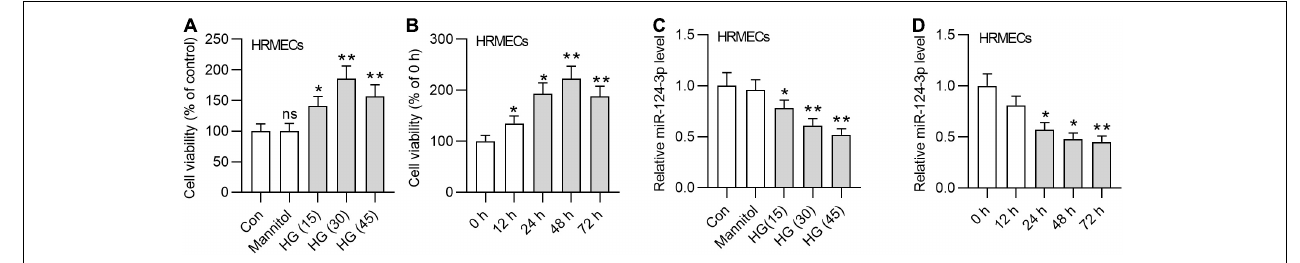
FIGURE 1 | MiR-124-3p was downregulated in HG-stimulated HRMECs. (A) The viability of HRMECs treated with 5 mM glucose, 5 mM glucose plus 30 mM mannitol, 15 mM glucose, 30 mM glucose, 45 mM glucose for 24 h was detected by CCK-8 assay. (B) The viability of HRMECs treated with 30 mM glucose for 0 h, 12 h, 24 h, 48 h, and 72 h was detected by CCK-8 assay. (C) The expression level of miR-124-3p in HRMECs treated with 5 mM glucose, 5 mM glucose plus 30 mM mannitol, 15 mM glucose, 30 mM glucose, 45 mM glucose for 48 h was detected with RT-qPCR analysis. (D) The expression level of miR-124-3p in HRMECs treated with 30 mM glucose for 0 h, 12 h, 24 h, 48 h, and 72 h was detected with RT-qPCR analysis. ns indicates no significance, * P < 0.05, ** P < 0.01, *** P <